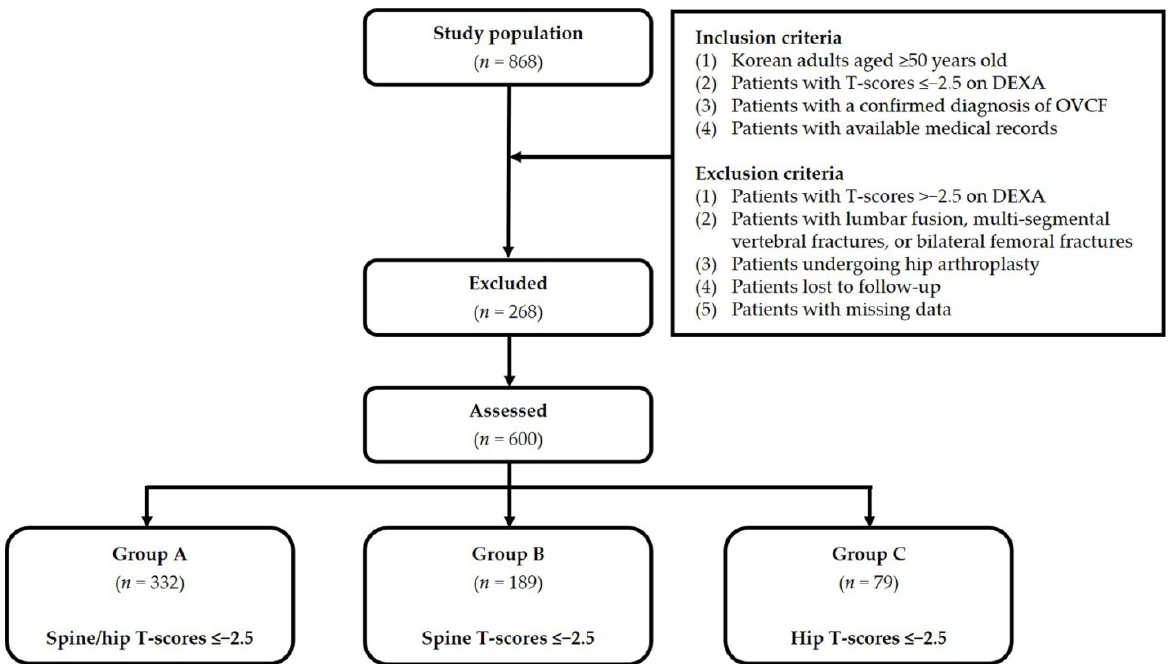
Figure 1. Disposition of the study patients. Abbreviations: OVCF—osteoporotic vertebral compression fracture; DEXA—dual-energy X-ray absorptiometry.